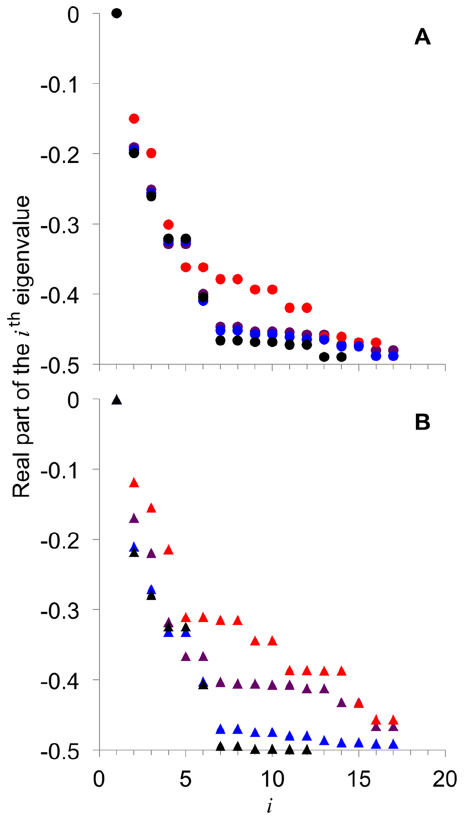
Figure 3. Real parts of the eigenvalues corresponding to the fitted model parameters from Figure 2. ( A ): Eigenvalues of a particular color are generated by the corresponding combination of AMY and BAM given in Figure 2 for WT CLD; ( B ): like ( A ) for Atisa1-1 CLD. The zero eigenvalue is for i =1. The higher eigenvalues are shown in Figure